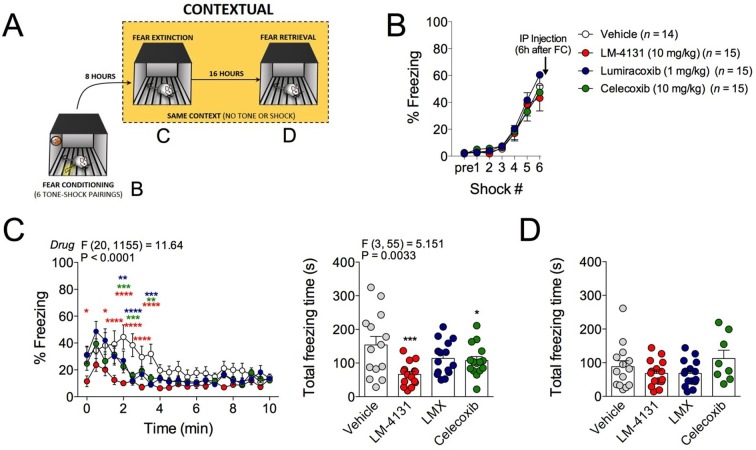
Effects of COX-2 inhibition on contextual fear conditioning.(A) Timeline for contextual fear conditioning. Data from each time point shown in correspondingly labeled panel (B–D). (B) No differences in freezing behavior between groups were observed during conditioning. Drugs were administered 6 hr after conditioning (2 hr before fear retrieval). (C) Time course and summary of effects of LM-4131, Lumiracoxib (LMX), or Celecoxib on conditioned fear expression during context re-exposure. (D) Effects of LM-4131, LMX, and Celecoxib on contextual freezing on a second context re-exposure. Significant F and P values for two-way ANOVA (C) and one-way ANOVA (D) shown above figure. *p<0.05, **p<0.01, ***p<0.001, ****p<0.0001 by Holm-Sidak post hoc analysis. Color of * indicates significance level of comparison between each drug and vehicle; red, LM-4131; blue, LMX; green, Celecoxib.